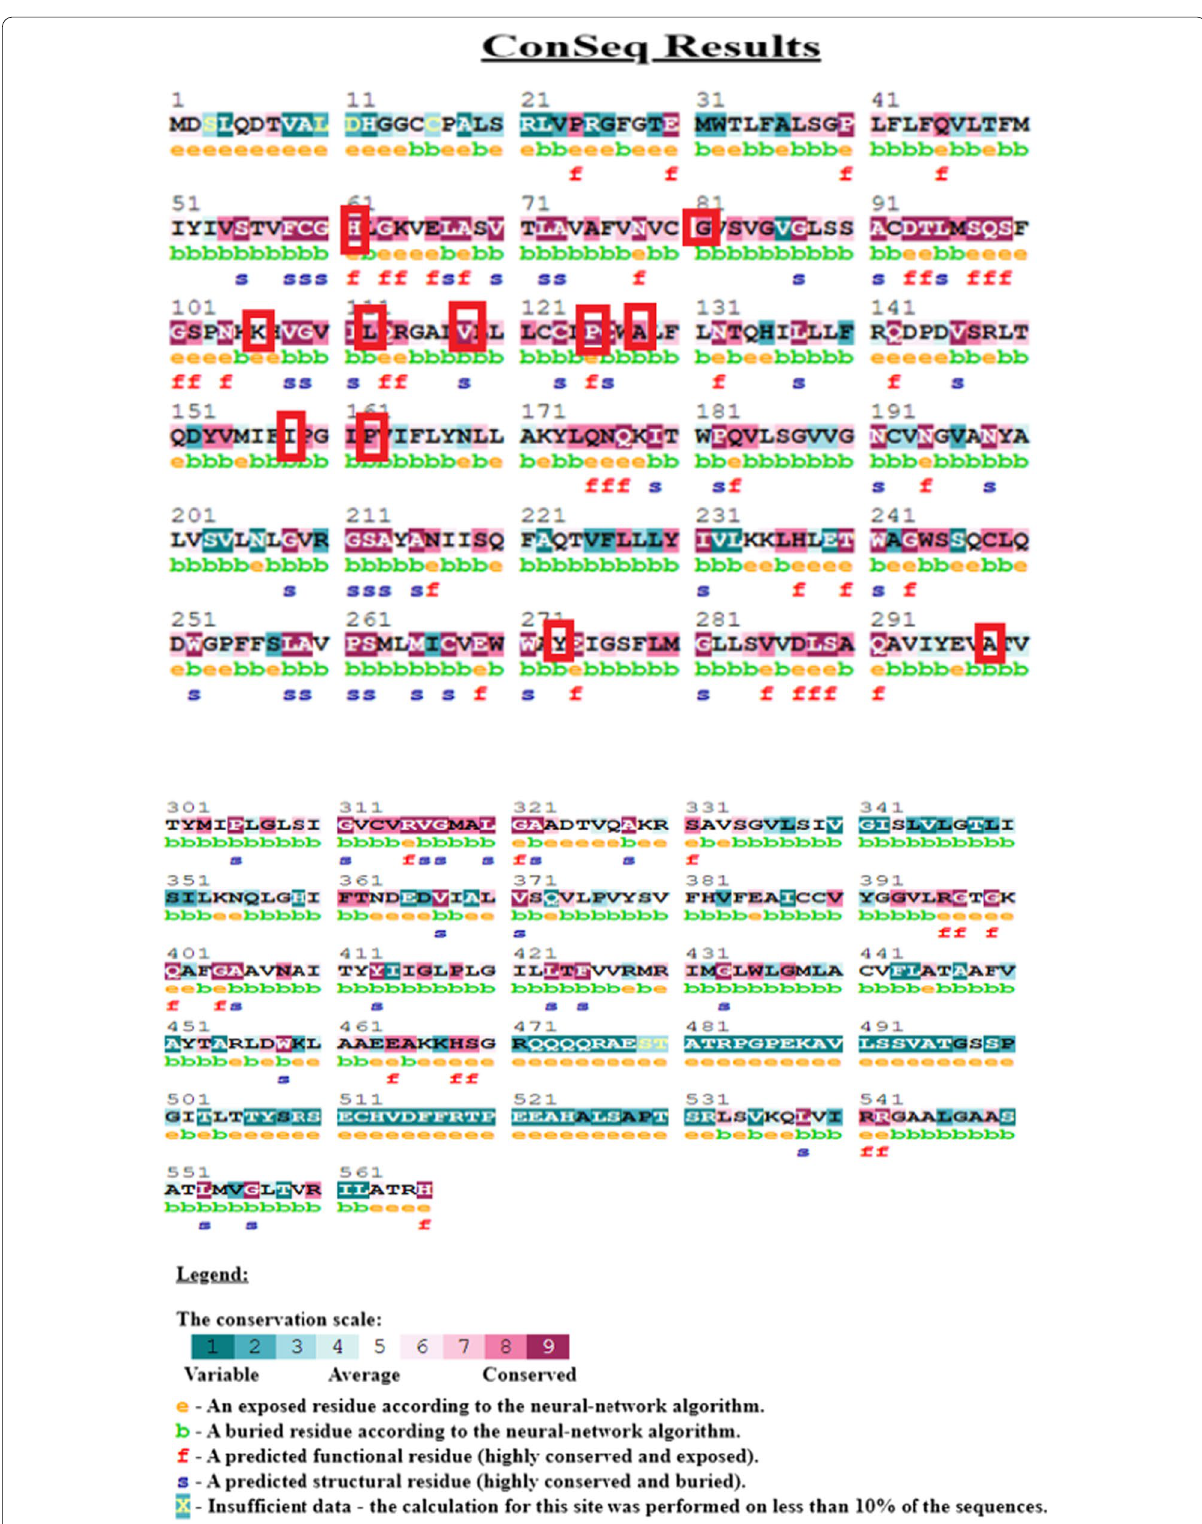
Fig. 2 Evolutionary conservancy of MATE2 generated by